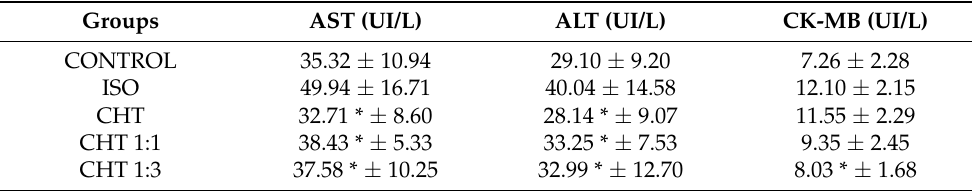
Table 3. Serum cardiac injury markers in rat isoprenaline-induced myocardial ischemia. Groups